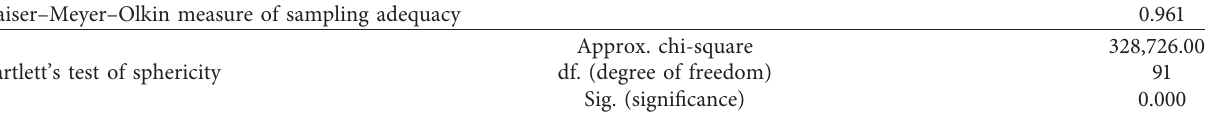
Table 4: KMO and Bartlett’s